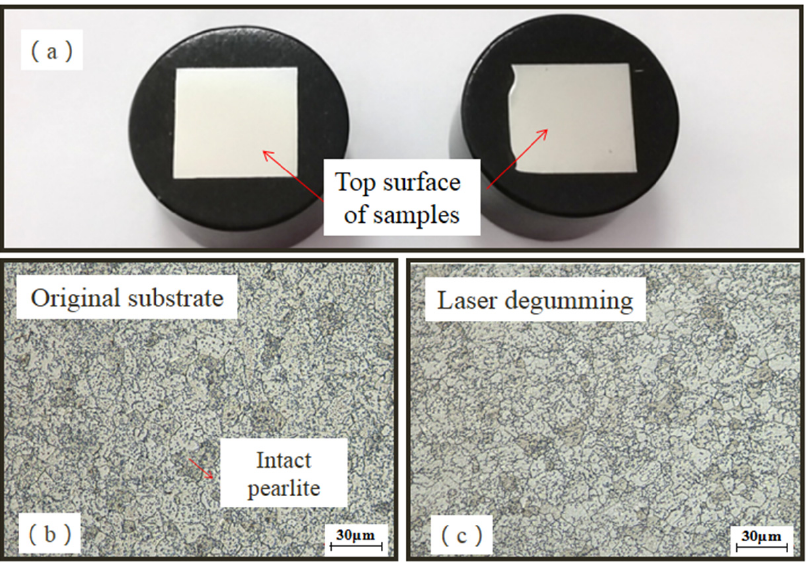
Figure 9. Sample preparation for metallographic examination ( a ) and micro-structures on the top surface of original substrate ( b ) and laser-degumming sample ( c ).